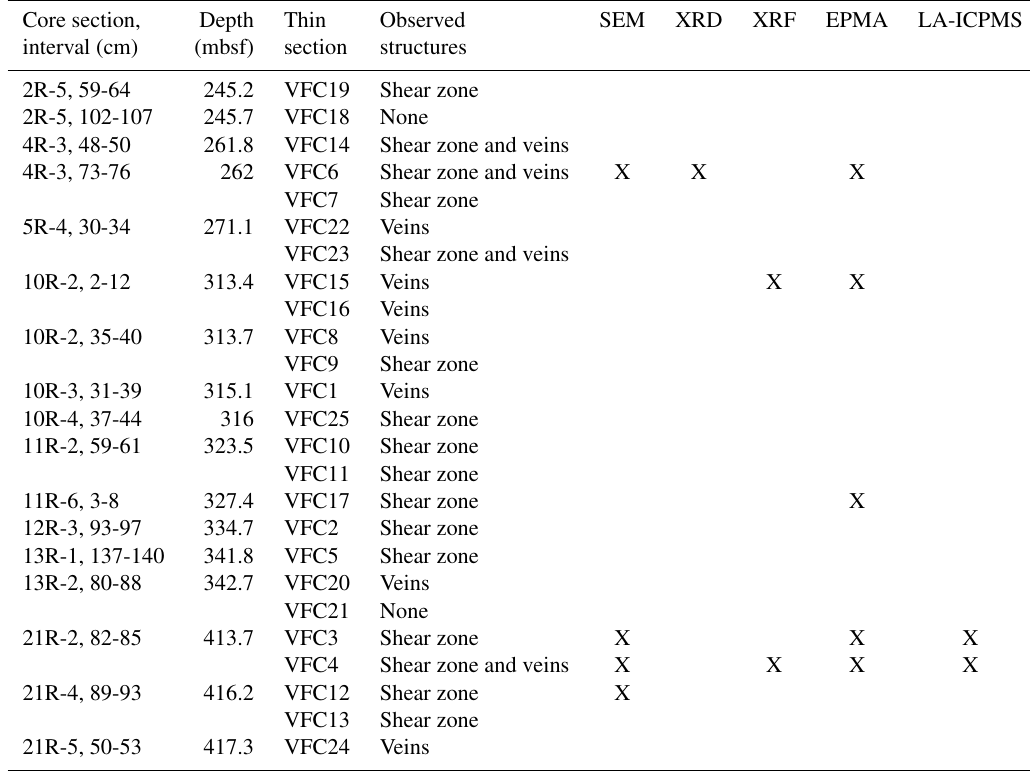
Table 1. Summary of studied samples from cores at site C0001, of structures observed, and of analyses carried out on them. Core section,